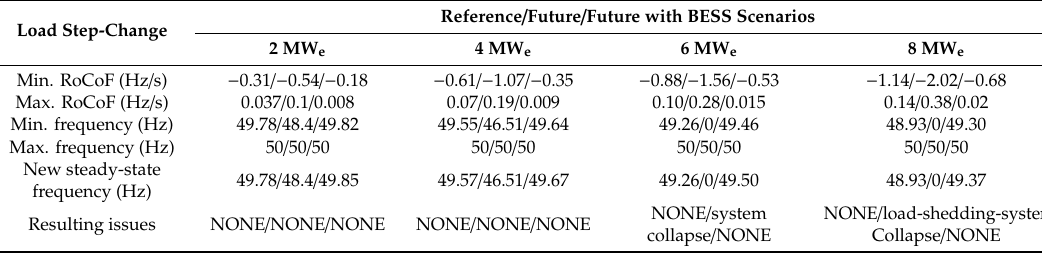
Table 7. Results for the worst cases of the reference and future